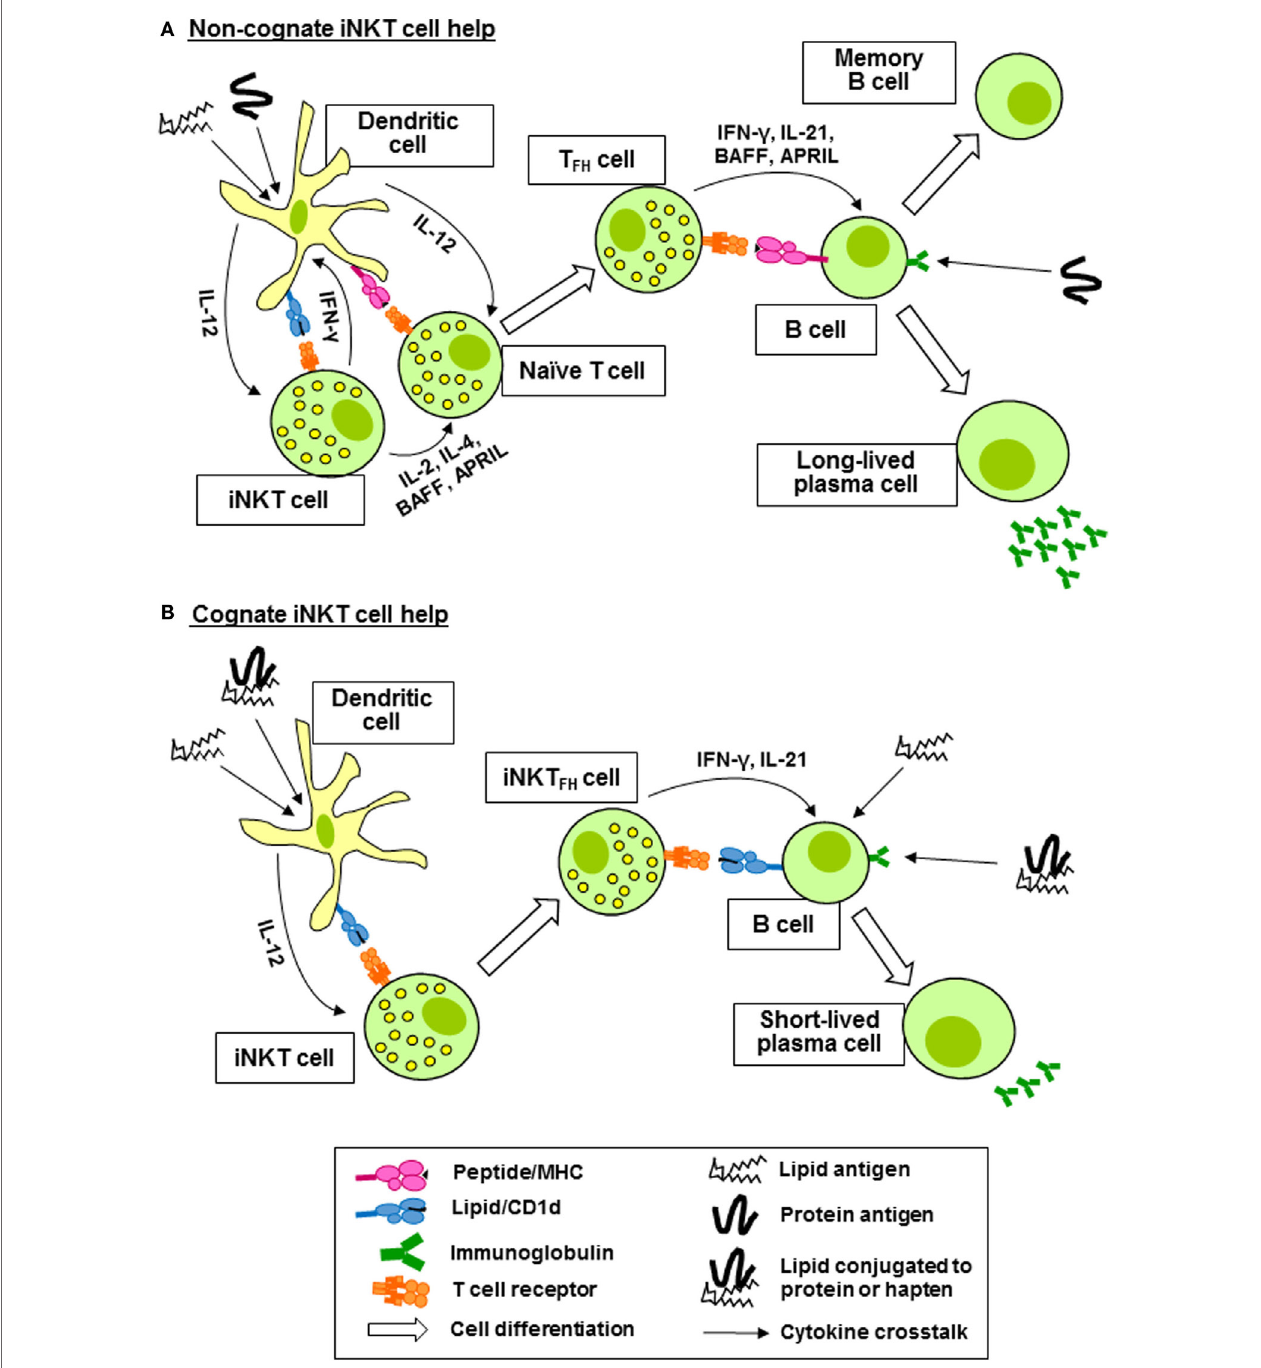
FigURe 2 | Invariant natural killer T (iNKT) cells provide non-cognate and cognate help for antigen-specific B cells. (A) Coadministration of protein antigen and an iNKT cell ligand, such as α -galactosylceramide (lipid antigen) results in internalization by a dendritic cell (DC) and simultaneous presentation of peptide fragments of the protein antigen on major histocompatibility complex (MHC) class II to a naïve CD4 + T cell and of the lipid antigen on CD1d to iNKT cells. IFN- γ production by the iNKT cell reciprocally promotes MHC class II antigen presentation and expression of CD40 by the DC, whereas IL-2, IL-4, B cell activation factor (BAFF), and a proliferation-inducing ligand (APRIL) production promotes maturation of the peptide-specific CD4 + T cell into a follicular helper T (T FH ) cell. The T FH cell then provides antigen-specific help for the proliferation of B cells in germinal centers, affinity maturation, antibody class switching, and the generation of long-lived antibody- secreting plasma cells and memory B cells. (B) iNKT cells recognizing lipid antigens presented by DC differentiate into follicular helper invariant natural killer T (iNKT FH ) cells capable of activating B cells specific for lipid antigens or proteins or haptens conjugated to the lipid antigens. B cell activation is mediated by CD40 and CD80/86 ligation by the iNKT FH cells and the production of IL-21 and IFN- γ . Cognate B cell help from iNKT cells results in plasmablast expansion, germinal center formation, modest affinity maturation, and primary class switched antibody